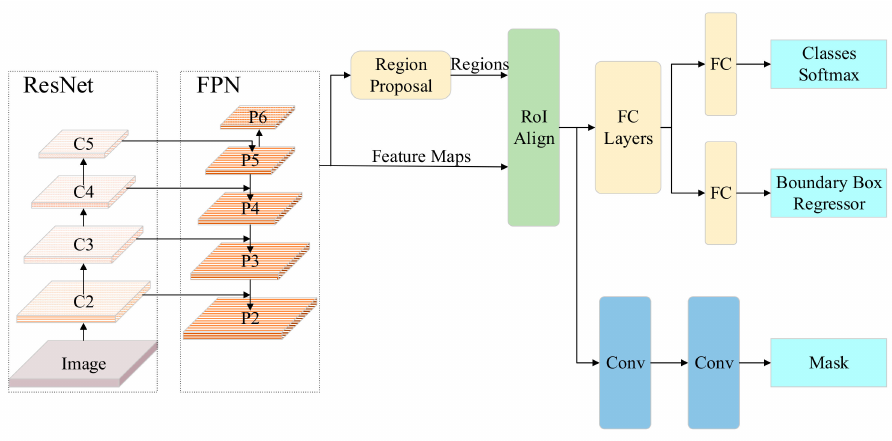
Figure 1. Mask R-CNN model structure